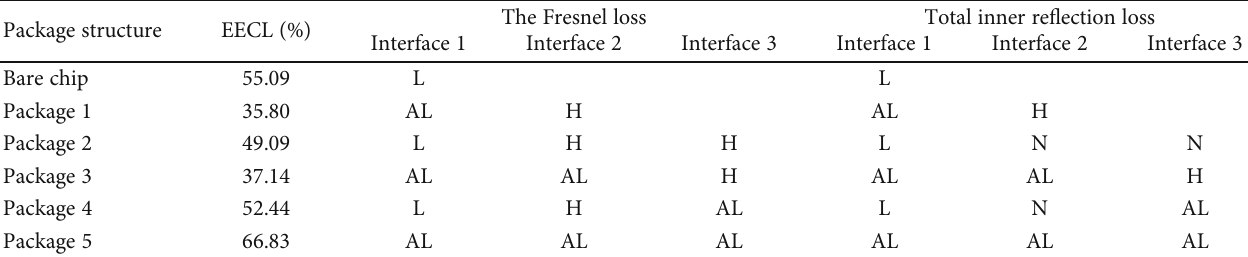
Table 2: Comparison of two losses of di ff erent package structure